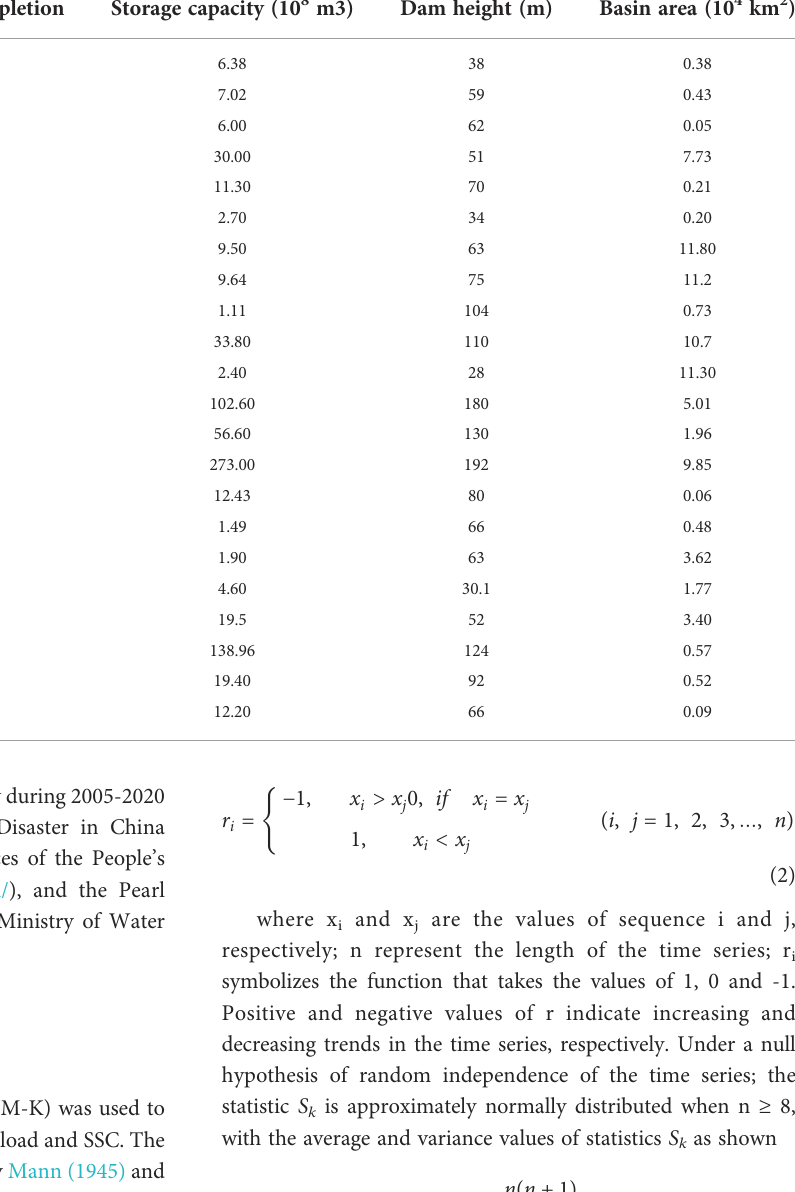
TABLE 2 Summary information of large reservoirs constructed in the Pearl River Basin.